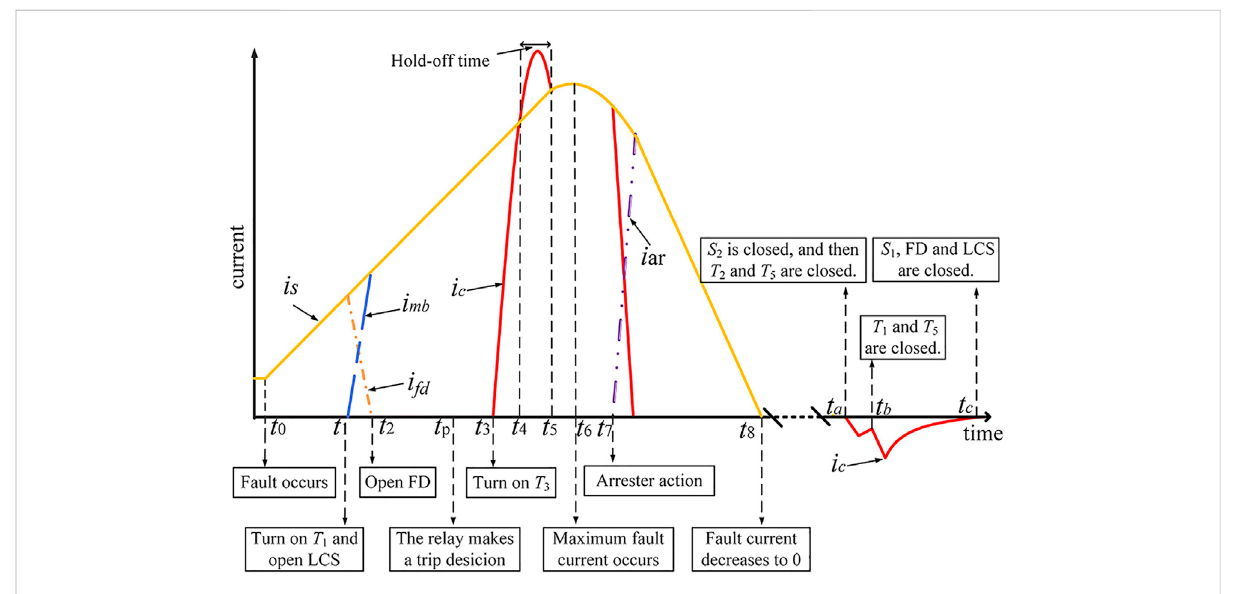
FIGURE 2 Current curves during interrupting fault currents and reclosing with a transient